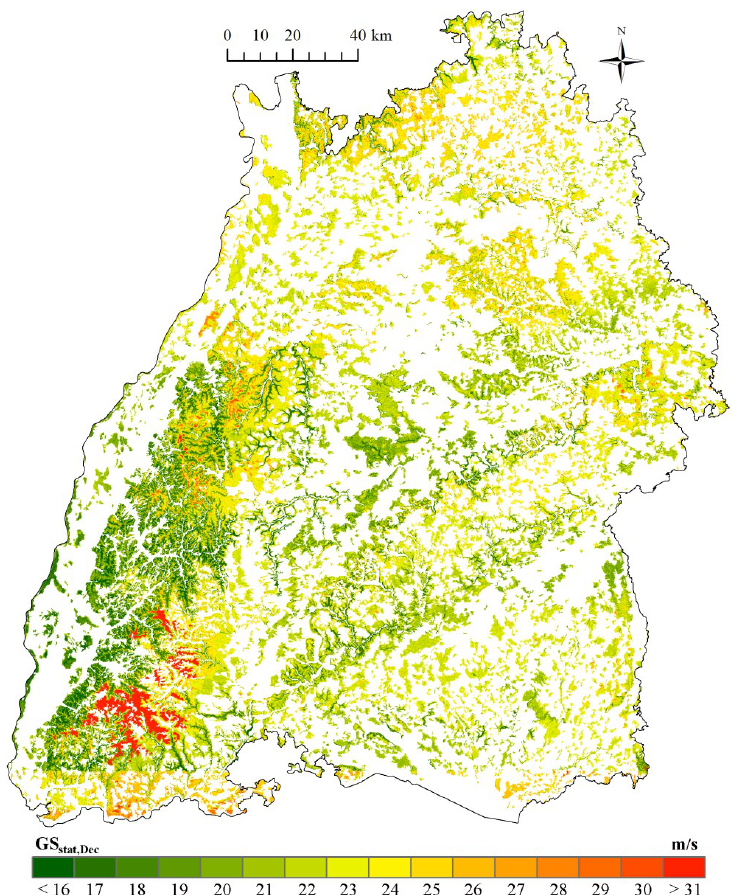
Figure 4. Map of statistical gust speed of December for a return period of five years ( GS stat,Dec ) covering the forest area.